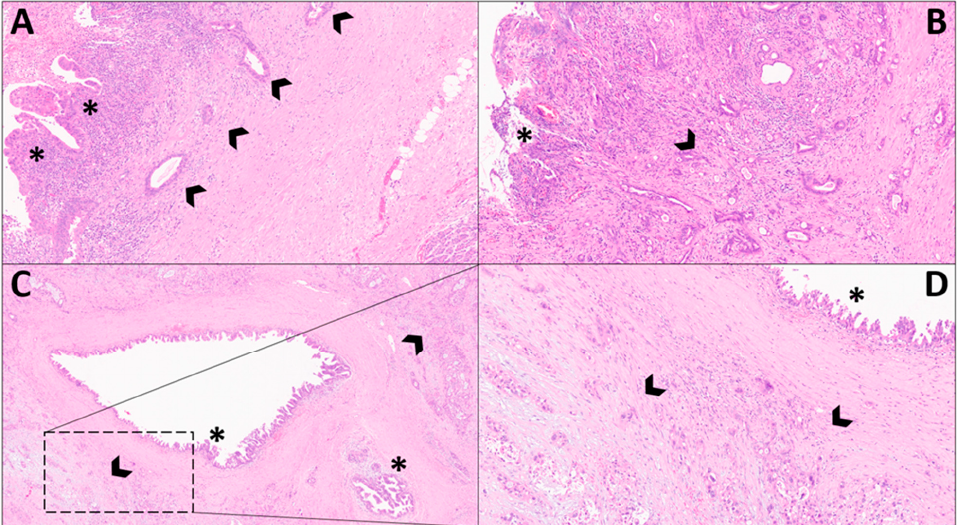
Figure 1. Highly illustrative figure showing the most typical histological features of distal extrahepatic cholangiocarcinoma (dCCA) and pancreatic ductal adenocarcinoma (PDAC). ( A ) This figure shows the presence of a dCCA composed of well-differentiated infiltrative glands (arrowheads), arising from a biliary intraepithelial neoplasia with high-grade dysplasia (asterisks) (Hematoxylin-eosin, original magnification: 10×). ( B ) This figure shows the presence of a dCCA growing around the choledocus and composed of moderately differentiated infiltrative glands (arrowhead); due to an extensive ulceration in the choledocus lumen (asterisk), the potential presence of biliary dysplasia cannot be evaluated. A desmoplastic stromal reaction is also evident (Hematoxylin-eosin, original magnification: 10×). ( C , D ) These figures show the presence of a PDAC composed of poorly differentiated infiltrative glands (arrowheads), with associated pancreatic intraepithelial neoplasia of the main and branch ducts (asterisks). A desmoplastic stromal reaction is also evident (Hematoxylin-eosin, original magnification ( C ): 4×, ( D ): 20×).